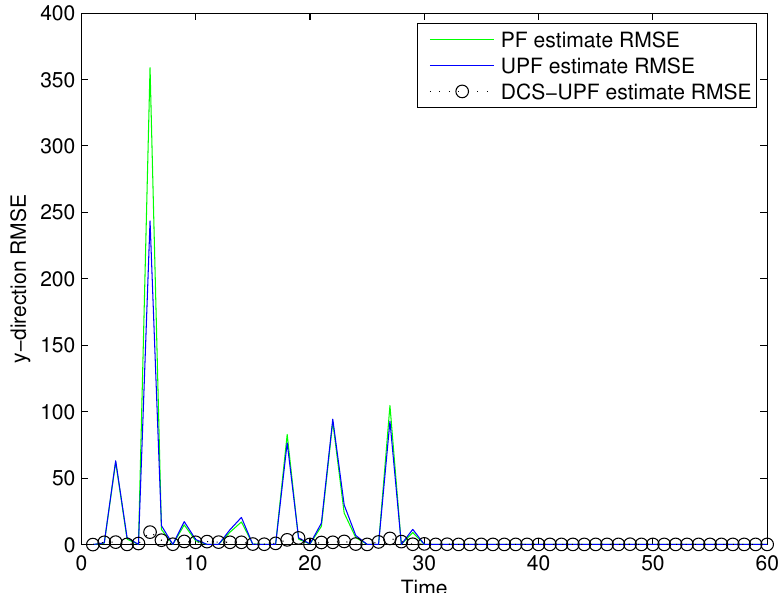
Figure 10. The tracking errors of three methods in Y-direction by changing R and Q. For the UPF algorithm, the accuracy of the trajectory tracking depends on the number of particles. Within a certain range, they are directly proportional. Figures 11 and 12 demonstrate the number of effective particles in PF, UPF, and DCS-UPF. The number of effective particles in PF, UPF and DSC-UPF are represented by the blue curve, black curve and green curve, respectively. We can also find that the DSC-UPF has more effective particle numbers. The reason for this phenomenon is that particles are sampled separately in each subspace, so the number of particles distributed in each subspace becomes increasingly uniform. Meanwhile, it solves the problem of sparse particle distribution in the subspace. Therefore, DSC-UPF has much higher accuracy than both PF and